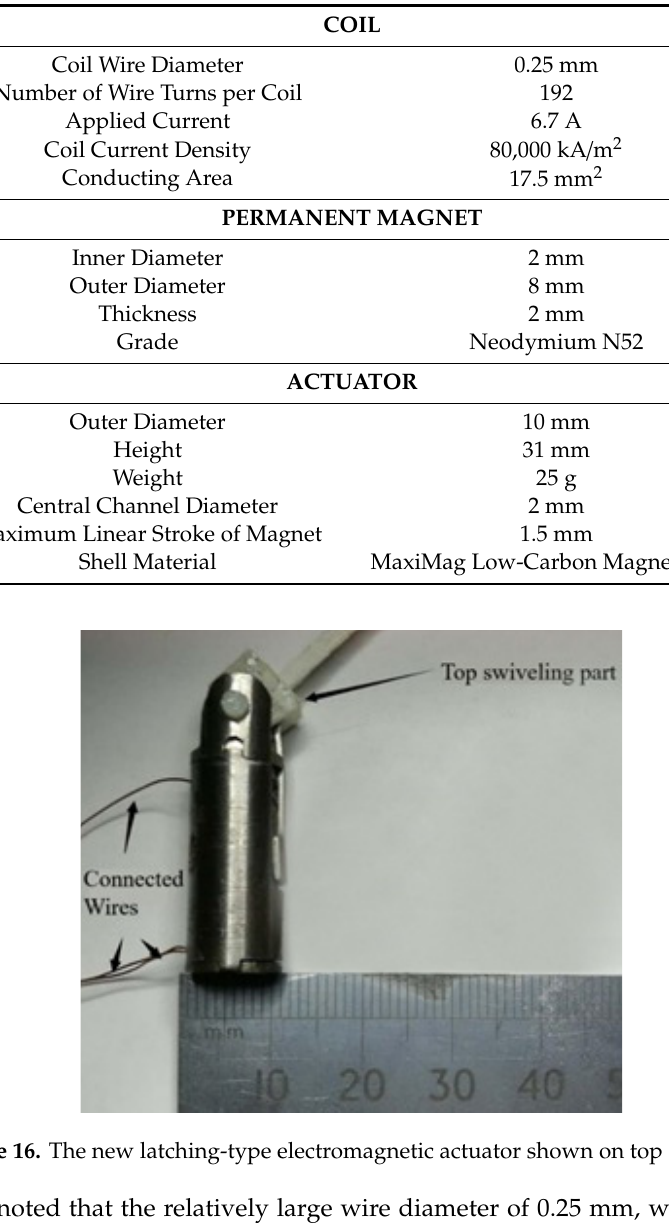
Table 4. Detailed parameters of the optimised actuator.